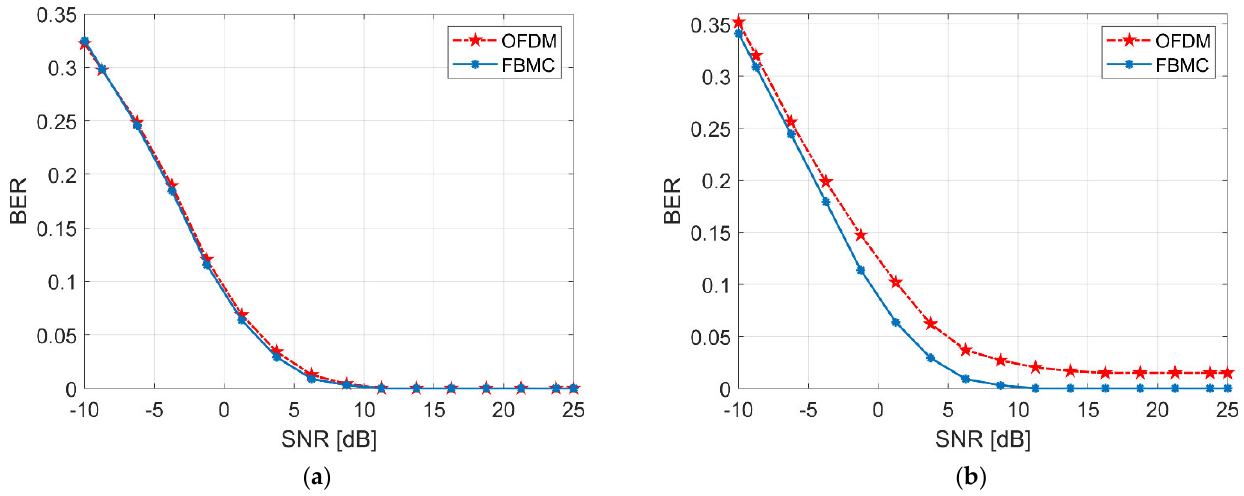
Figure 10. Comparison of communication performance under multipath delay (communication results with multipath delay less than CP ( a ) and communication results with multipath delay greater than CP ( b )).